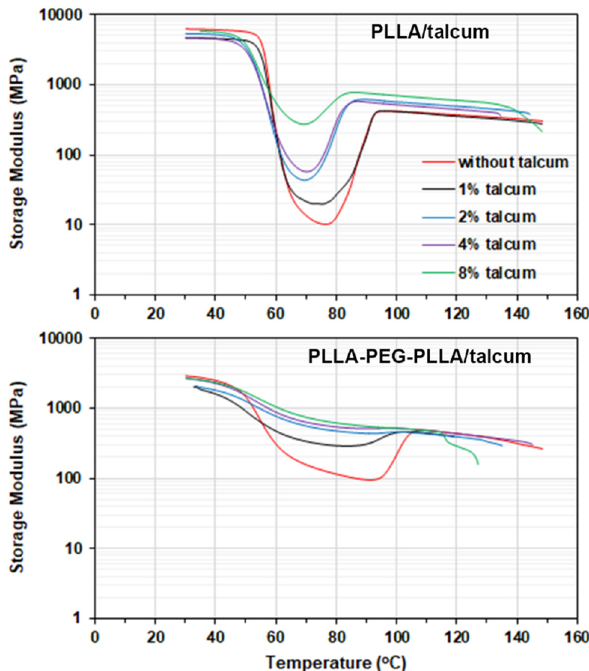
Figure 6: Changes of storage modulus as a function of temperature fromDMAof ( above ) PLLA/talcum and ( below ) PLLA - PEG - PLLA/talcum fi lms for various talcum contents.